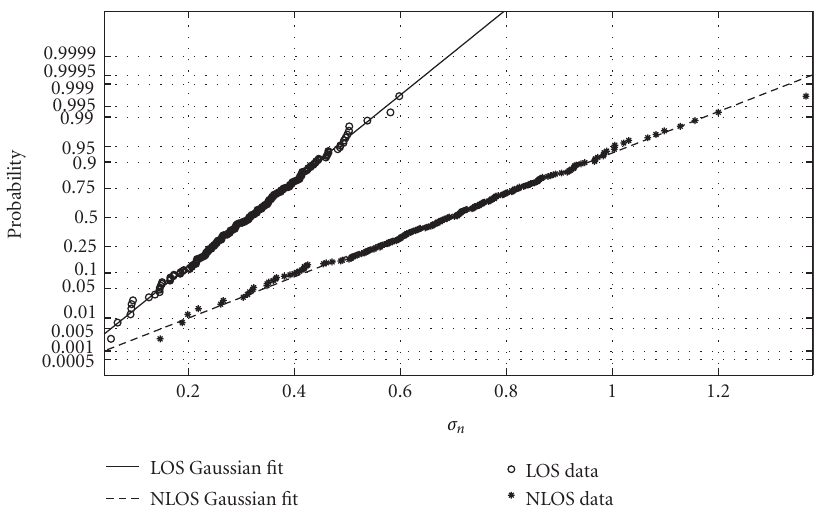
Figure 6: CDF of the standard deviation of path-loss exponent σ n over 201 frequency